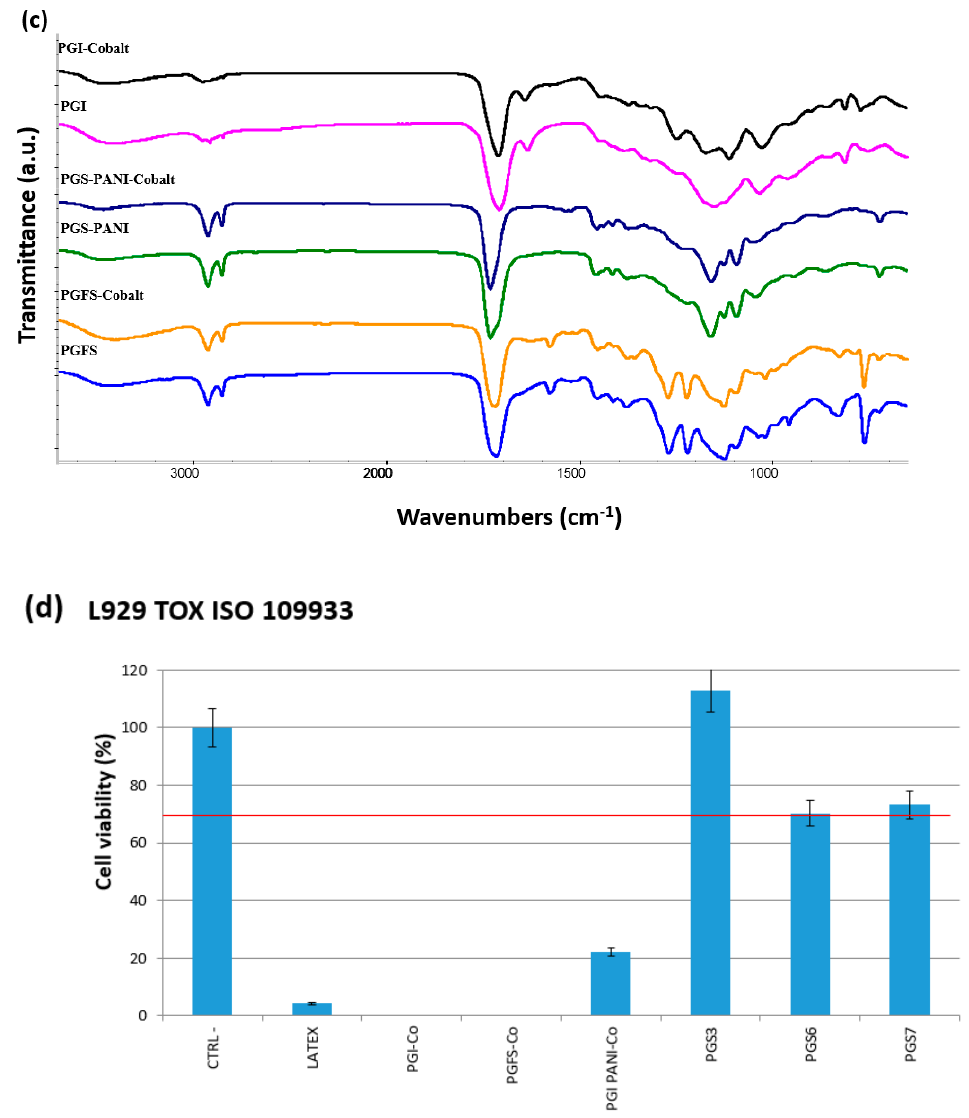
Figure 10. ( a ) Evolution of PGS7-Co and PGI-Co after immersion in a deionized water bath. ( b ) Comparison between infrared spectra of elastomer sheets from PGI-Co, PGS7-Co, and PGFS-Co, along with their classic melt-polycondensation-produced counterparts. ( c ) Photographs of FE-SEM observations of PGI-Co, PGS7-Co, and PGFS-Co surfaces (scale bars = 400 µ m). ( d ) Cytocompatibility tests following the ISO10993 standard protocol and performed with PGI-Co, PGFS-Co, PGS7-Co, PGS3, PGS6, and PGS7.